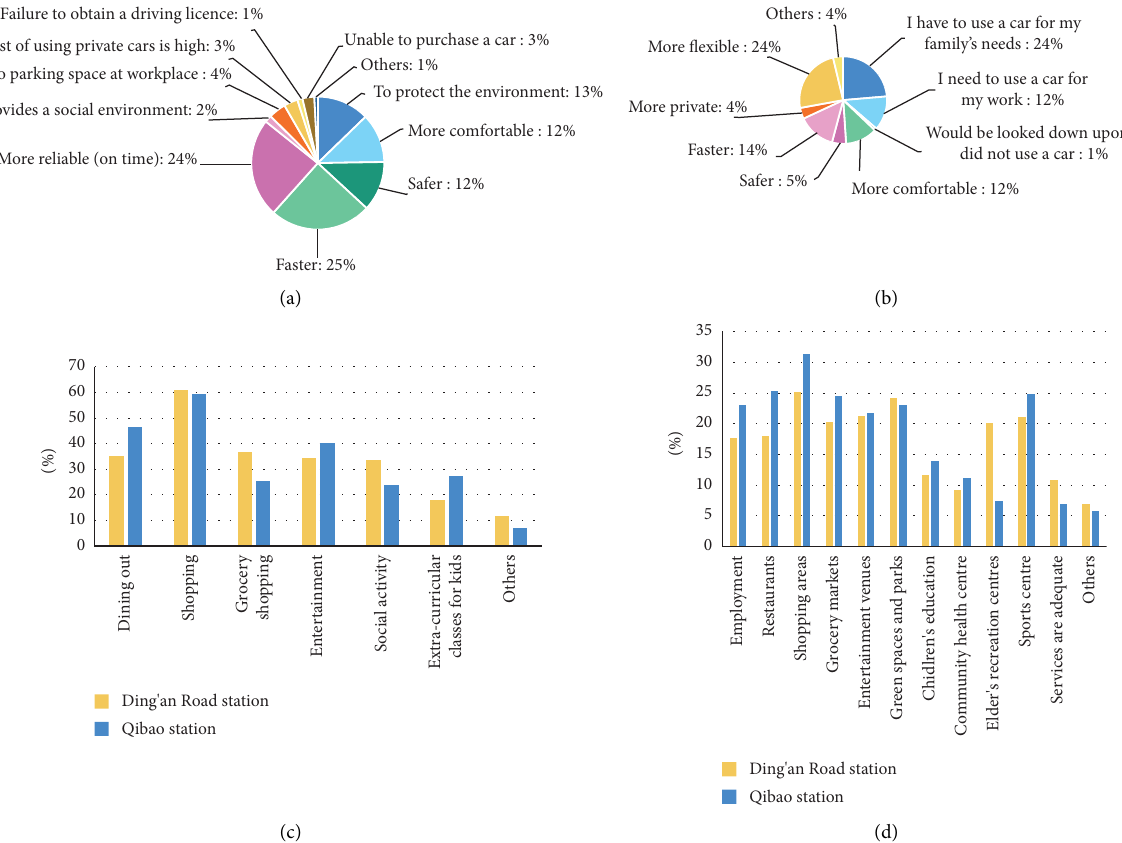
Figure 2: Additional travel information chart: (a) reasons for using metro, (b) reasons for using cars, (c) travel purposes at weekends, and (d) lack of services. Table 4: Logistic regression analysis results regarding the travel choices of residents living in TOD catchment areas. Independent